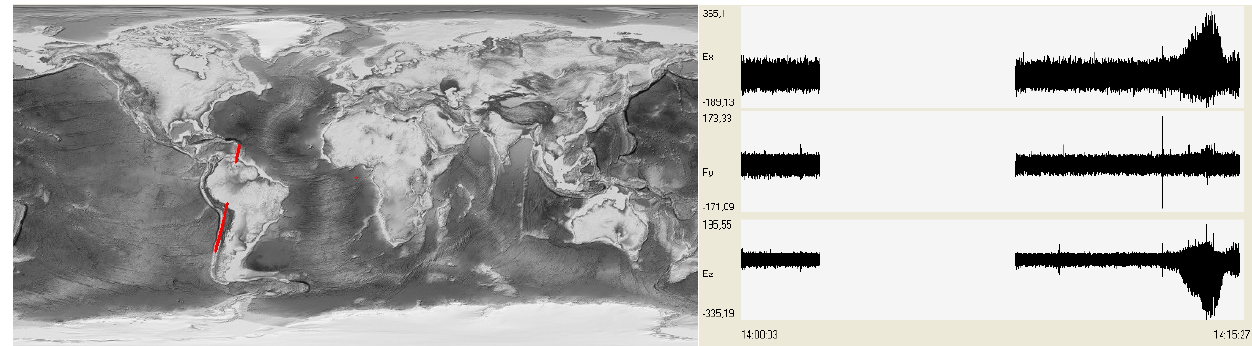
Figure 1. Typical ELF data of a half-orbit (orbit no. 302630 on 2010/02/26 day-side). It is shown that data are not available along the whole orbit, but only when the satellite was in “burst mode”.